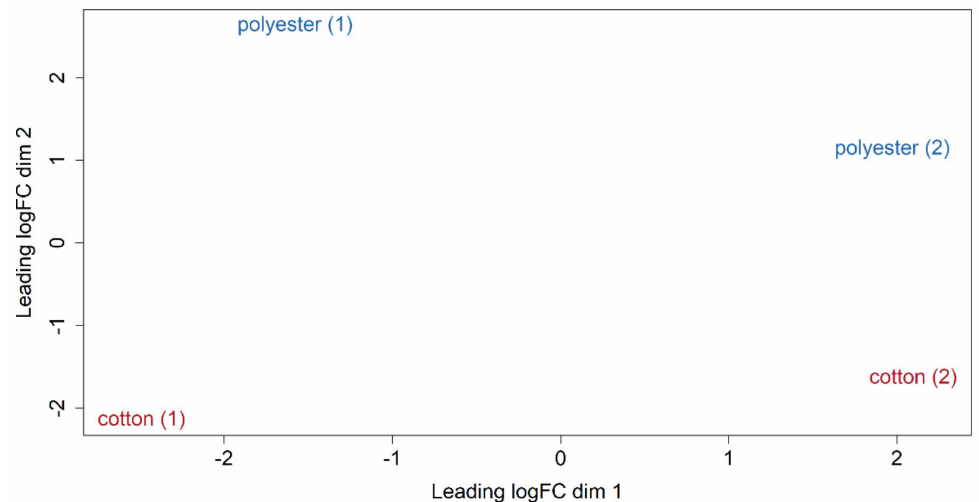
Figure 3. Multi-dimensional scaling (MDS) plot based on RNAseq expression profiles from different tissue type samples. The distances between the samples in the plot were calculated based on leading log2 fold changes (logFC) between each cotton and polyester sample, which were defined as the average log2-fold change for the 500 most differential genes between each pair of profiles [84]. The numbers in parentheses define the respective washing experiments. Here, the MDS plot for the Trinity assembly is shown. The very similar MDS plot for the Spades assembly can be found in Figure